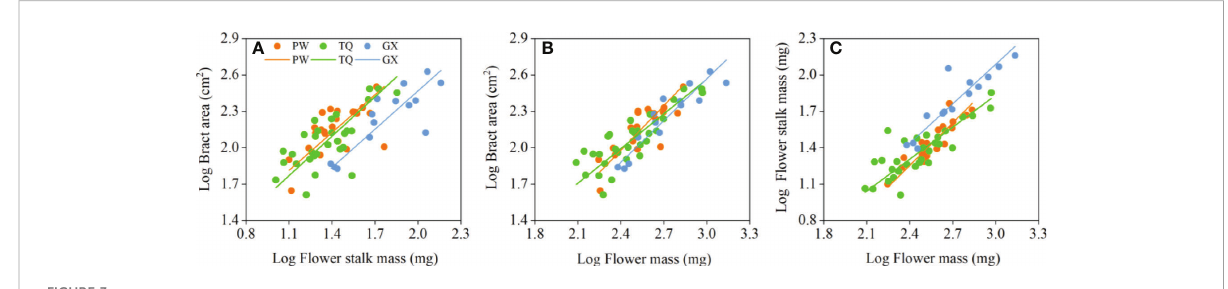
FIGURE 3 Growth relationships between bract area and fl ower stalk mass (A) , bract area and fl ower mass (B) , fl ower stalk mass and fl ower mass (C) in three latitude regions. PW, Pingwu; TQ, Tianquan; GX, Gongxian.